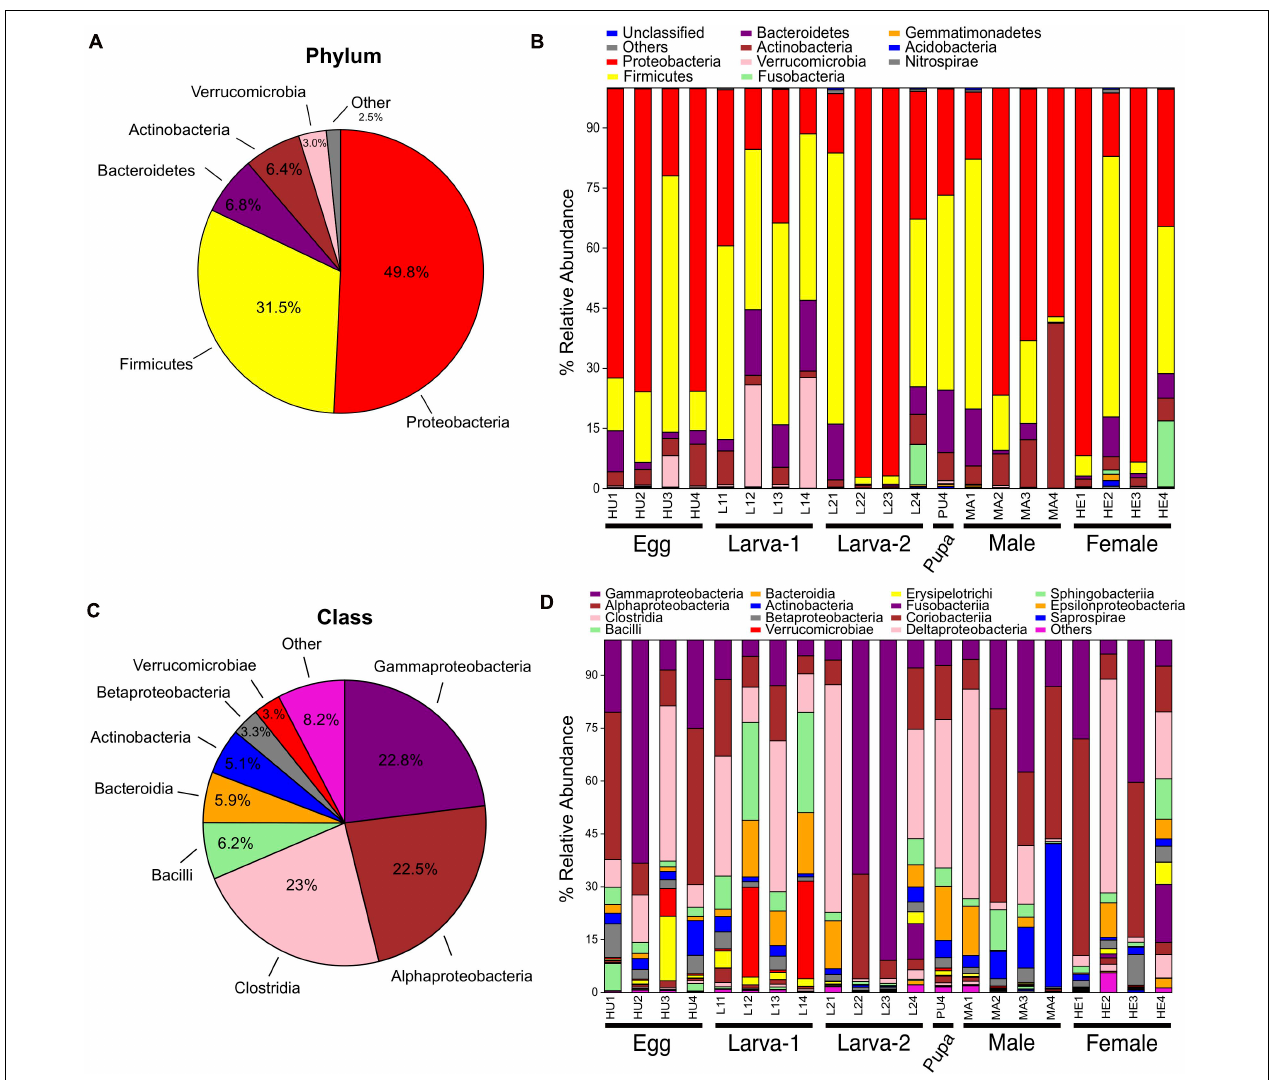
FIGURE 2 | Bacterial taxonomic distribution and the Phylum and Class level within the gut-associated microbiota of Hypothenemus hampei . Composition at Phylum level for all samples merged (A) and for developmental stages (B) . Composition at Class level for all samples merged (C) and for developmental stages (D)